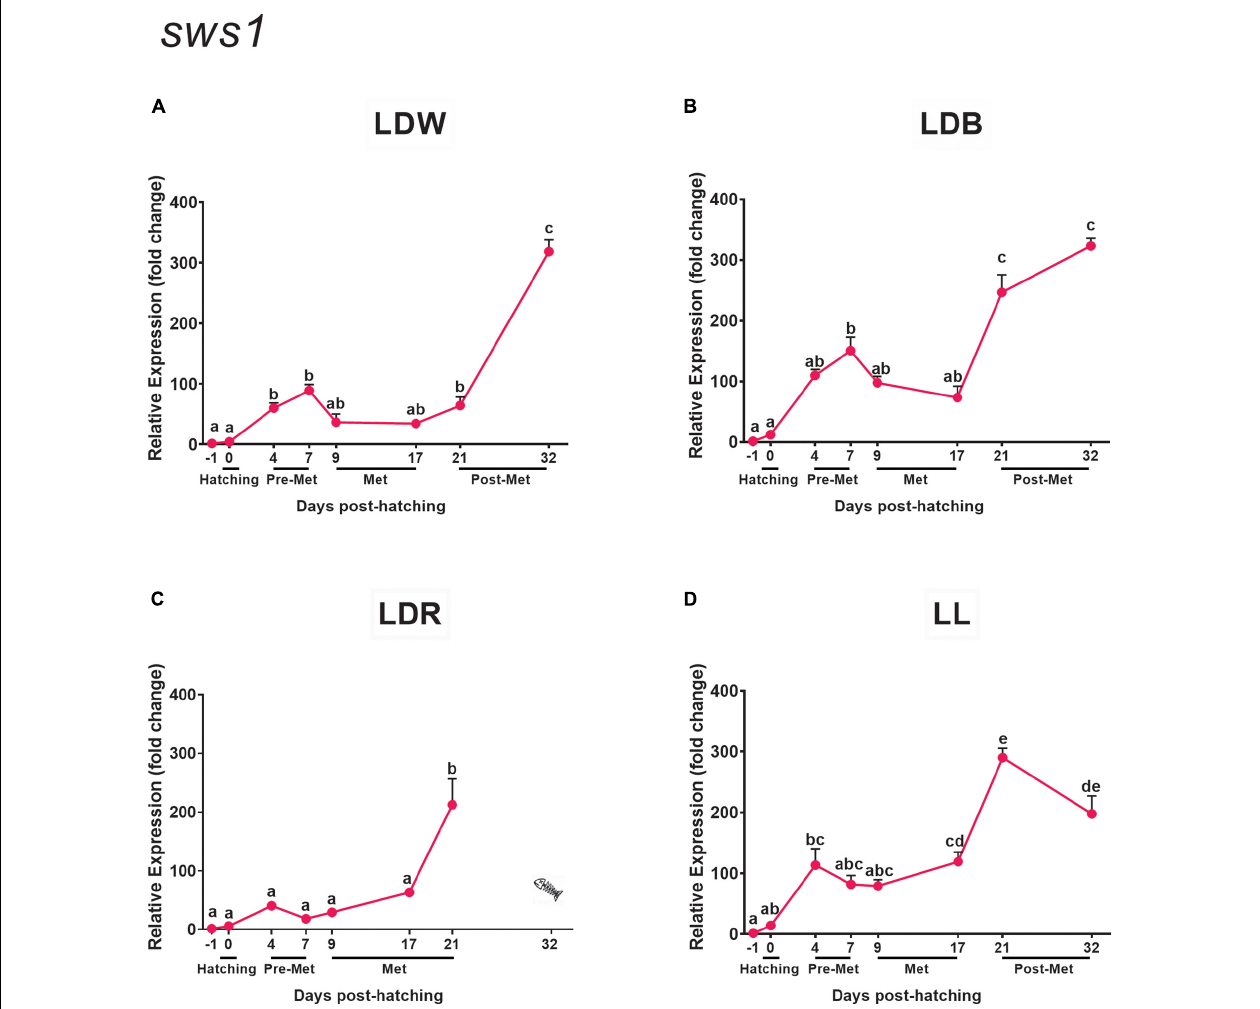
FIGURE 3 | Expression of ultraviolet cone opsin ( sws1 ) in embryos, larvae, and juveniles of the Senegalese sole on dph –1 (embryos), dph 0 (hatching), dph 4–7 (pre-metamorphosis, Pre-Met), dph 9–17 (metamorphosis, Met), and dph 21–32 (post-metamorphosis, Post-Met) analysed by RT-qPCR. For further information, see the legend in Figure 1